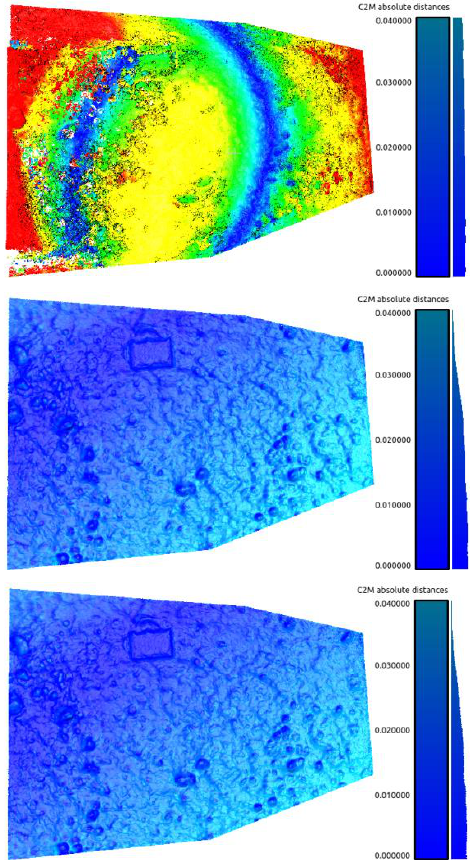
Figure 9. Evaluation of 3D reconstruction from each iteration (The green , yellow, red color in the first picture indicates that the error of this model is much larger than the color bar’s range: green (0.06m, 0.12m], yellow (0.12m, 0.18m] , red (0.18m,